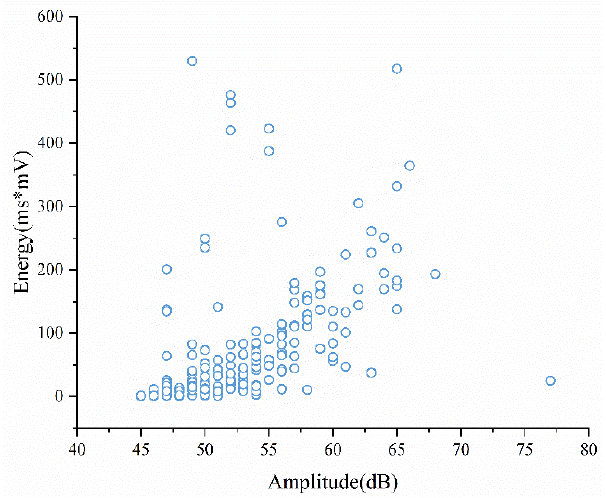
Figure 14. Amplitude-energy correlation diagram of cable noise signal of Yangmadao Bridge.